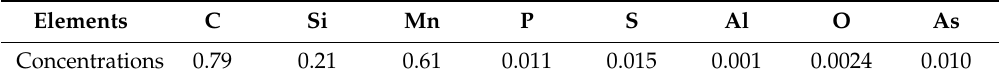
Table 1. Chemical compositions of the raw material